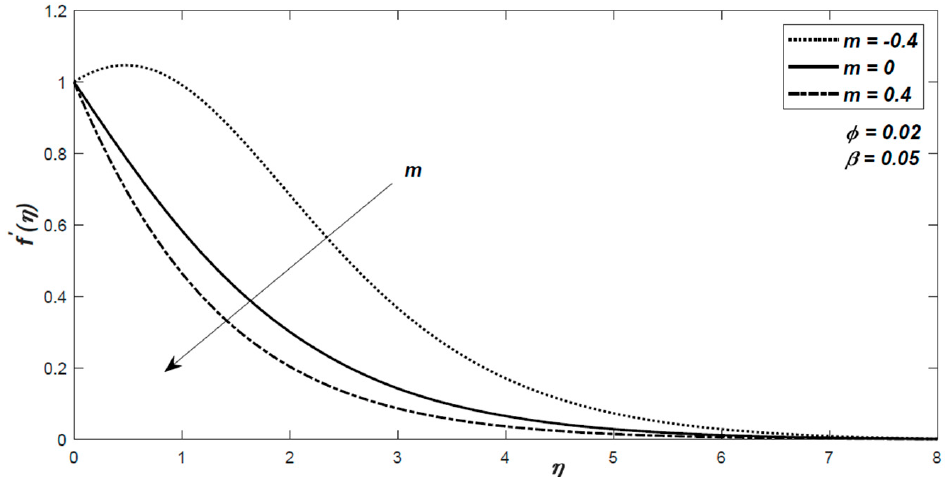
Figure 6. The variation of the nondimensional velocity for different values of the stretching parameter m .